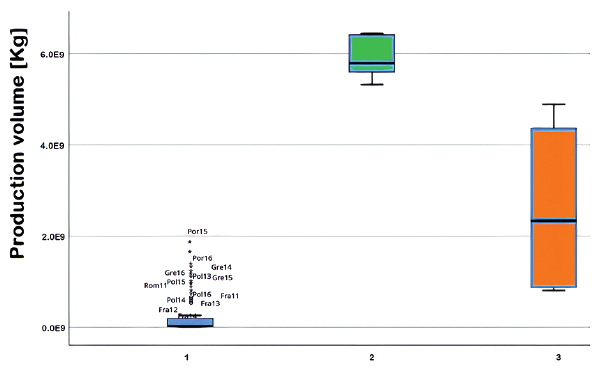
Figure 9. Post-crisis box diagram of production variable according to the clusters of the first two-stage clustering level (source: own elaboration)